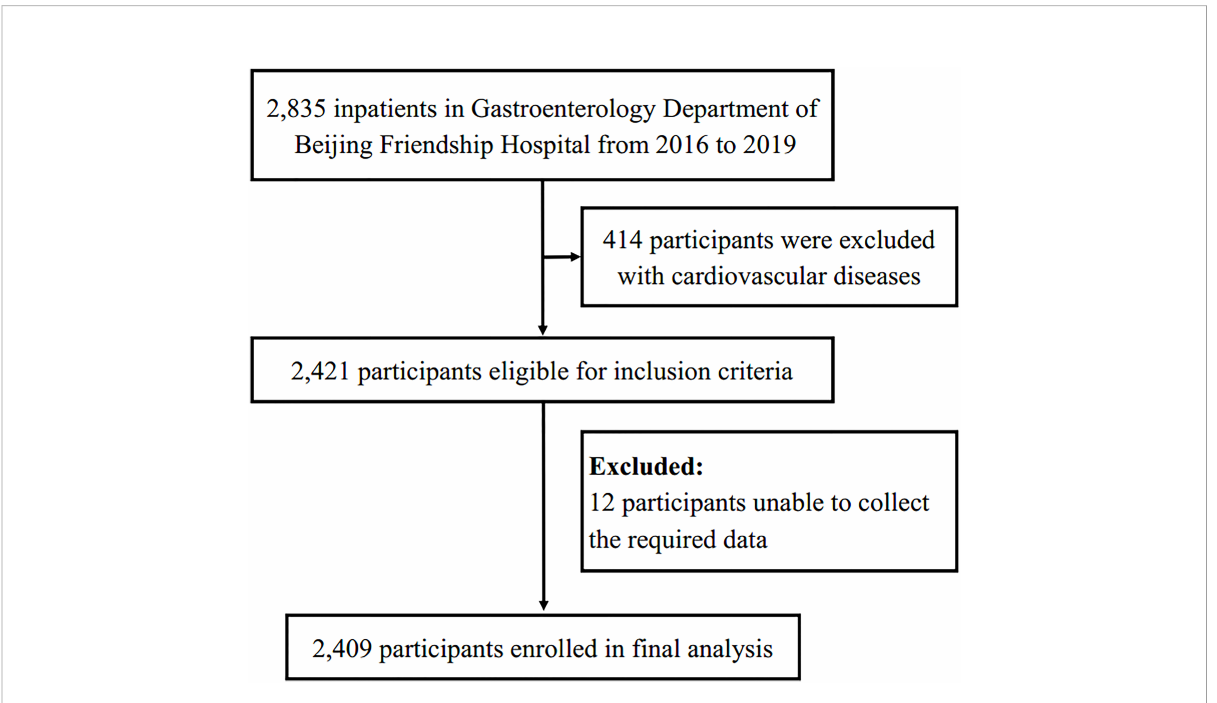
FIGURE 1 Flow chart of the study